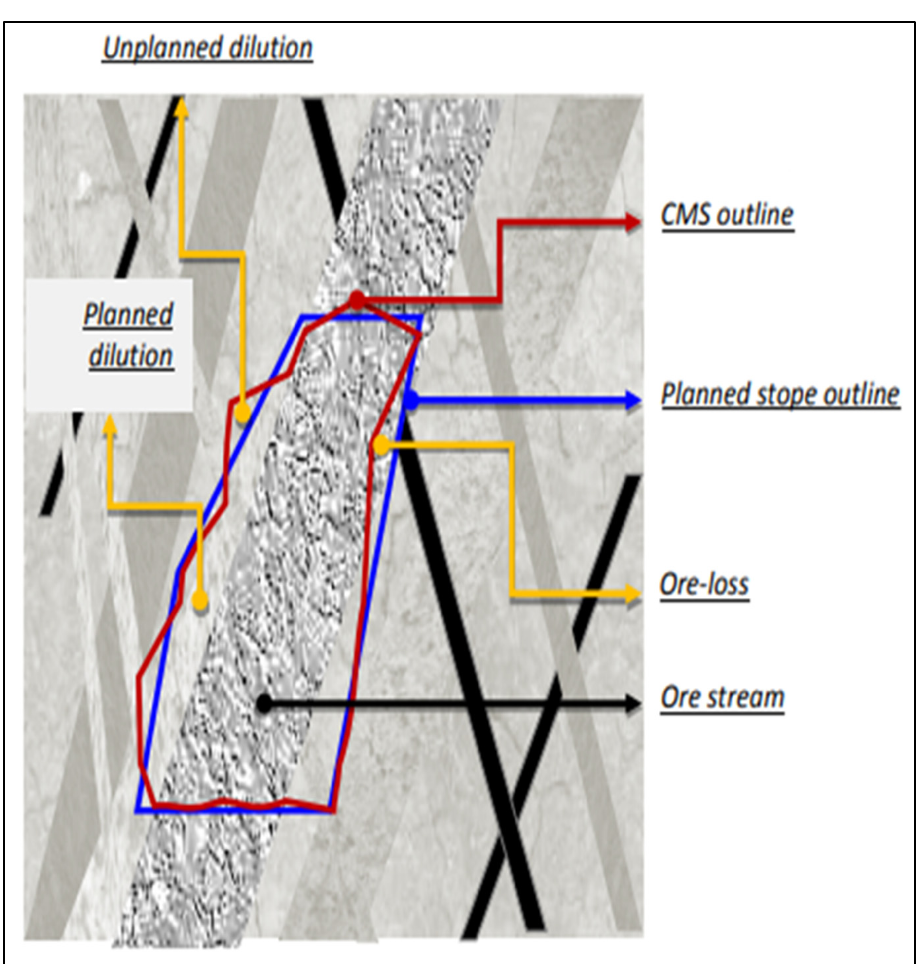
Figure 1. Ore dilution categorization by Jang [3].